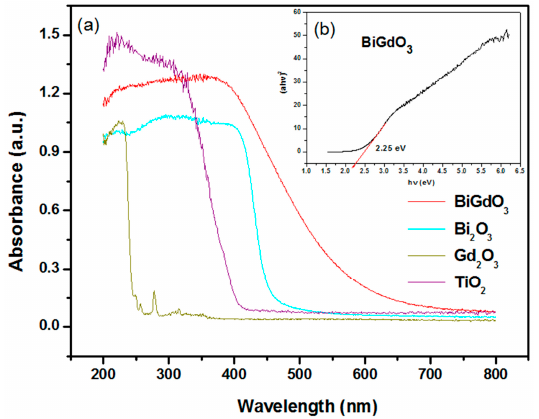
Figure 7. ( a ) UV-Vis diffuse reflectance spectra of BiGdO 3 , Bi 2 O 3 , Gd 2 O 3 and TiO 2 ; and ( b ) plot of ( α h ν ) 1/ n versus h ν for BiGdO 3